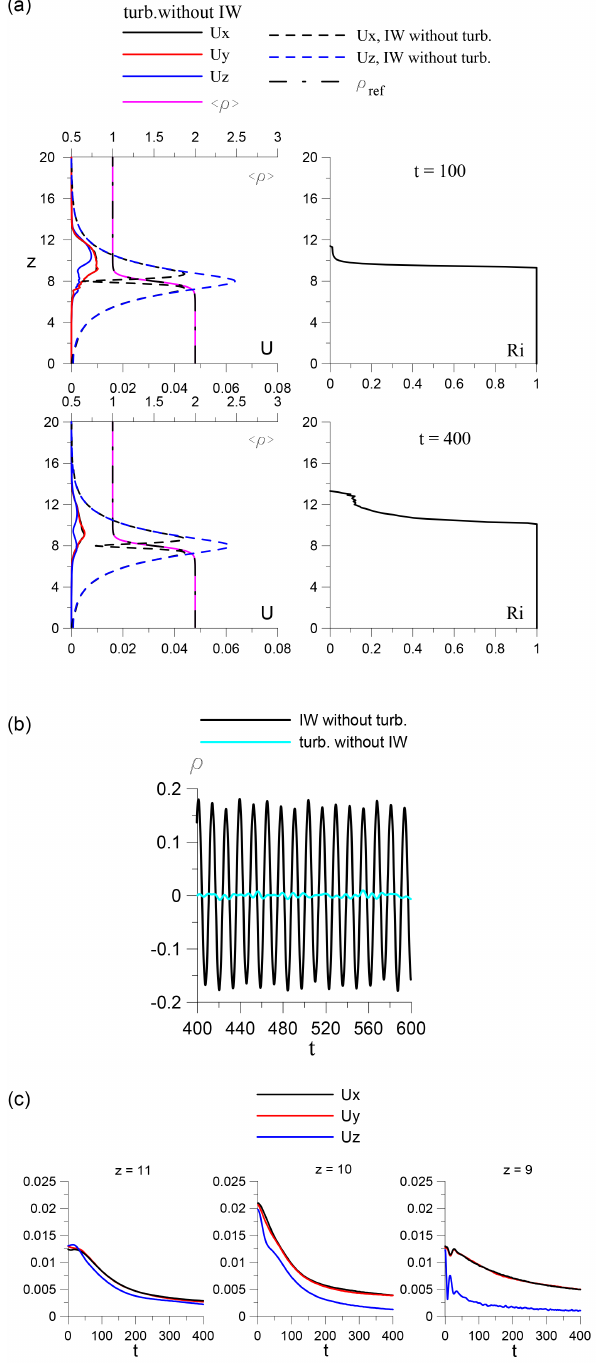
Figure 3. (a) Vertical profiles of the rms velocity components, U (cid:48) x , U (cid:48) y and U (cid:48) z , mean density < ρ > (left) and the gradient Richardson number, Ri g (right), obtained at time moments t = 100 and t = 100 in DNS with no initially induced IW. The reference (initial) density profile, ρ ref (z) , is shown in dash-dotted (black) line for comparison. Profiles of the rms velocity x and z components of IW without turbulence are also shown in dashed line. (b) Temporal development of the instantaneous density deviation at the point with coordinates x = 20, y = 10 and z = 8 (in the middle of the pycnolcine) obtained in DNS with initially excited IW without turbulence and initially excited turbulence without IW (in color). (c) Temporal development of the rms velocity components U (cid:48) x , U (cid:48) y and U (cid:48) z obtained at different z levels in DNS with no initially induced